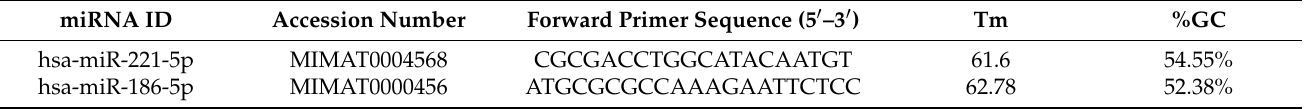
Table 2. Primers sequences used for quantitative real time PCR of